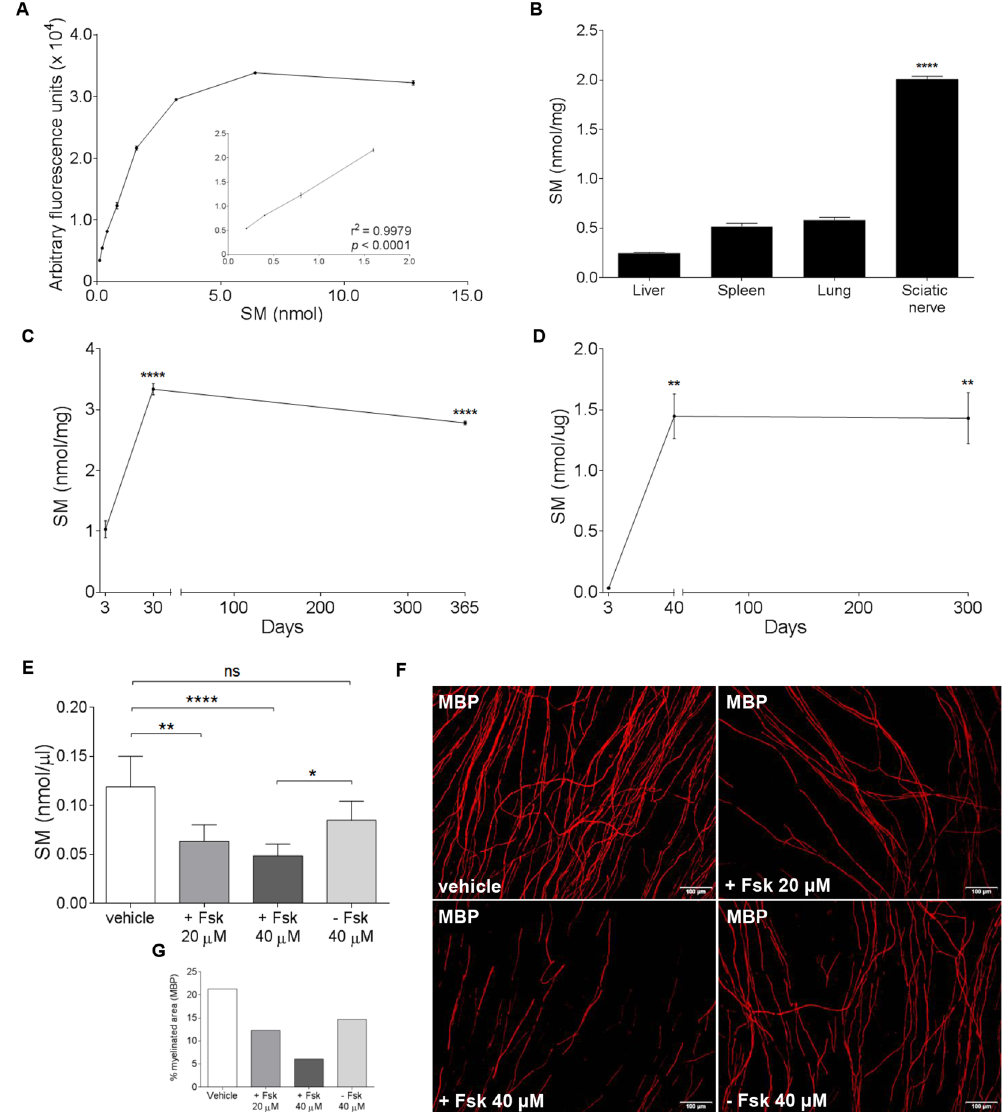
Figure 1. SM levels mirror both peripheral myelination during development and small myelin rearrangements ( A ) SM titration curve of a fluorescence-based assay showed a significant and reliable linearity from 0.2 to 1.6 nmol. ( B ) Quantification of SM in several tissues from 270-day-old rats displayed a specific enrichment in sciatic nerves. ( C , D ) SM levels in rat sciatic nerves and purified myelin progressively increased during development (sciatic nerve: 3-day-old, n = 5; 30-day-old, n = 8; 365-day-old, n = 3; purified myelin: 3-day-old, n = 3; 40-day-old, n = 3; 300-day-old, n = 3). ( E ). We treated DRG cultures with Forskolin (Fsk) 20 and 40 μ M to induce demyelination and then let them recover by Fsk removal. We found that SM was able to detect both demyelination and remyelination (n = 6). ( F , G ) Immunofluorescence staining of myelin by MBP in DRG cultures and quantification of MBP-positive myelinated fibers supported biochemical data. Scale bars: 100 µ m. Errors bars in A, B represent the SD; * p < 0.05, ** p < 0.01, *** p < 0.001, **** p < 0.0001, ns = not-significant. Goodness of fit (r 2 ) was determined by linear regression analysis. Holm-Sidak multiple comparison test after 1-way analysis of variance was used for statistical comparison in